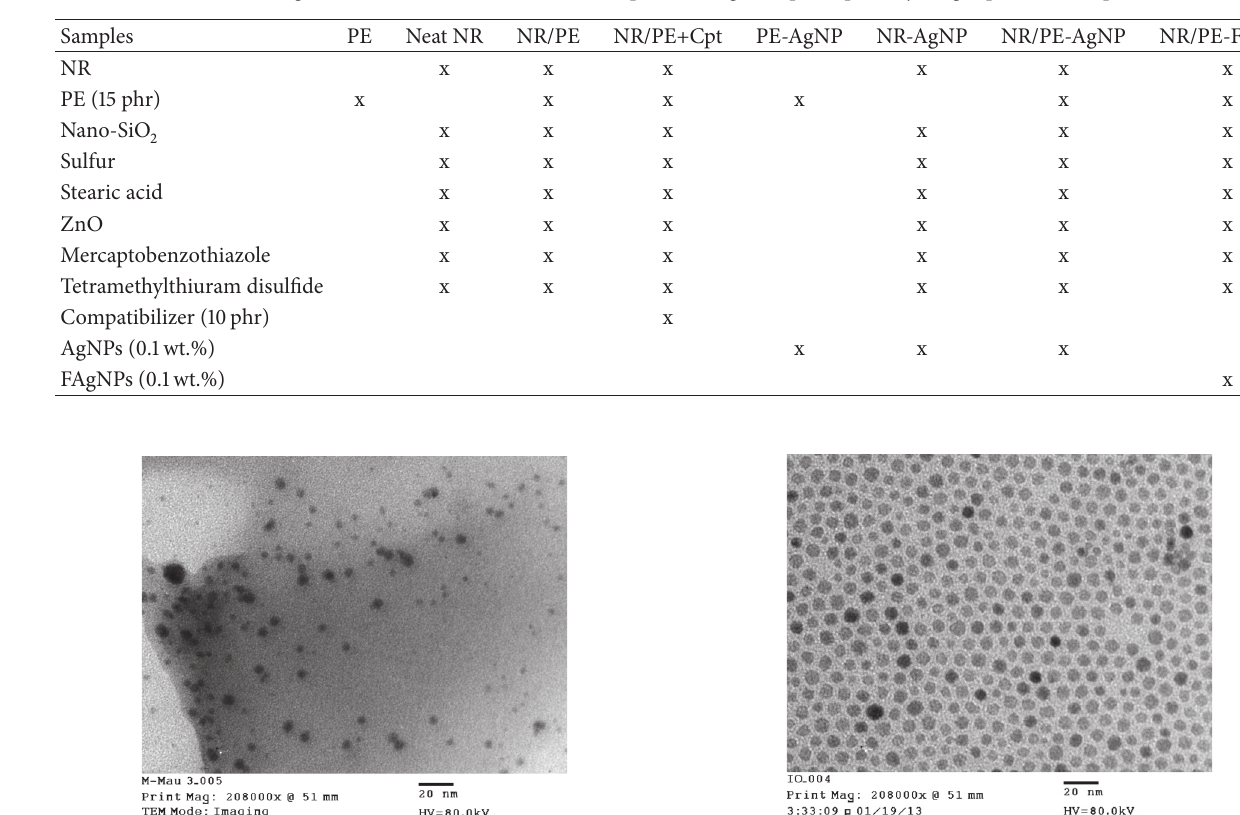
Table 1: Mix design of neat NR and NR/PE blends samples investigated (phr = parts by weight per hundred parts of NR).